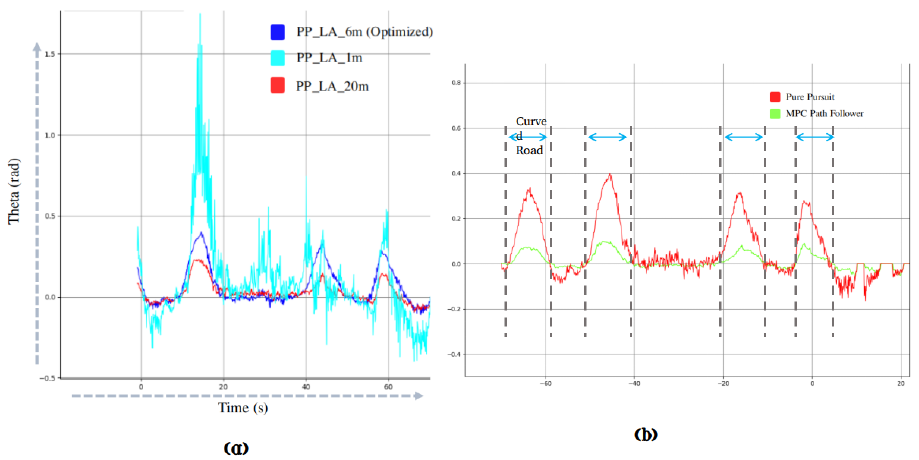
Figure 20. ( a ) illustrates the effect of look-ahead distance in pure pursuit. The look-ahead distance with different configuration is illustrated in the legend of the graph; for instance, the PP-LA-1m corresponds to 1m look-ahead distance in the pure pursuit. The look-ahead distance of 1m is more prone to noise, and produces more vibrations in the lateral control of the vehicle. Moreover, the look-ahead distance of 20 m, deviates the lateral control from the original track. The optimized look-ahead distance of 6m gives the optimal result with minimal error in contrast to former look-ahead distances. The steering angle for lateral control is shown by Theta (rad). ( b ) illustrates the graph of lateral error difference between MPC and pure pursuit [24] (Best viewed in